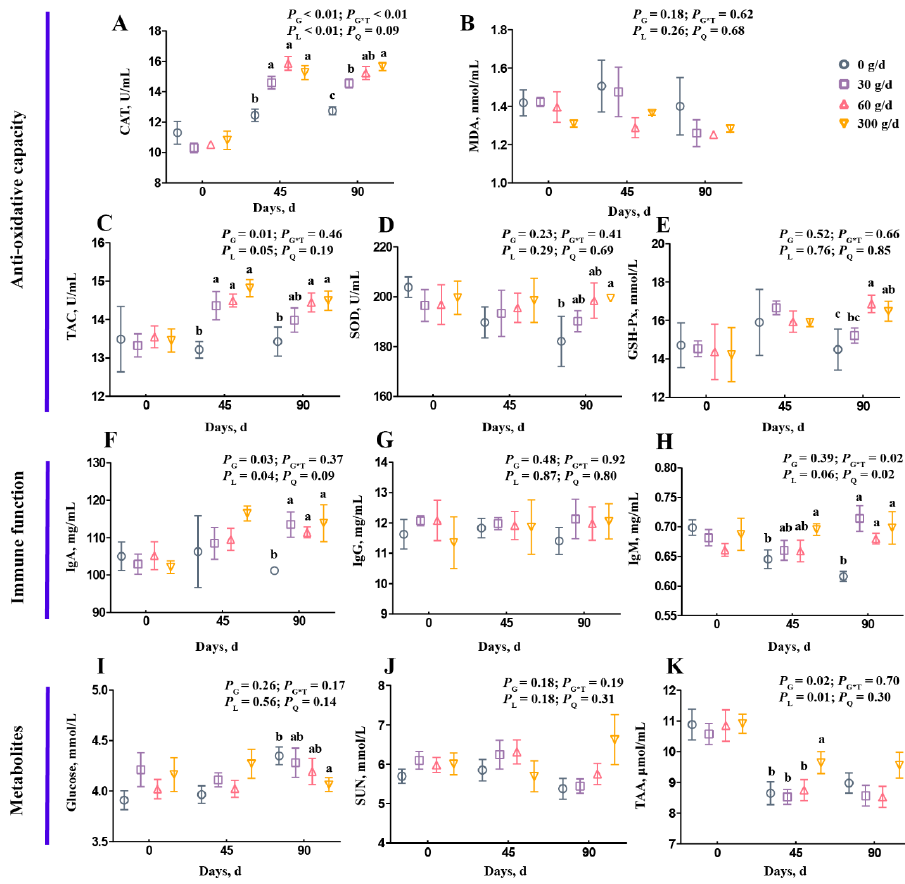
Figure 1. Effects of different amounts of Acremonium terricola culture on serum variables in lactating dairy cows. The serum variables were divided into three groups, including antioxidant capacity ( A – E ), immune function ( F – H ), and metabolites ( I – K ). Serum variables of dairy cows fed a diet with supplementation of ATC at 0, 30, 60, or 300 g/d were used. The effects included group effect and the interaction effect of group and time, as well as linear and quadratic effects. Different lowercase letters denote significant differences among treatments ( p < 0.05). ATC, Acremonium terricola culture; CAT, catalase; MDA, malonaldehyde; TAC, total oxidative capacity; GSH–Px, glutathione peroxidase; SOD, superoxide dismutase; IgA, immunoglobulin A; IgG, immunoglobulin G; IgM, immunoglobulin M; SUN, serum urea nitrogen; TAA, total amino acids. Mean ± SEM. n =